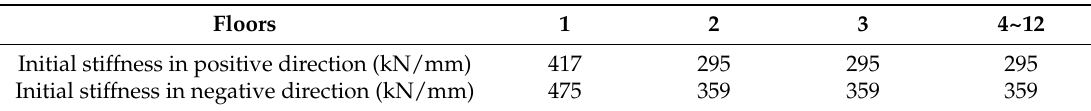
Figure 2. Full-scale three-story precast concrete shear wall substructure model. Table 1. Calculated parameters for test model.